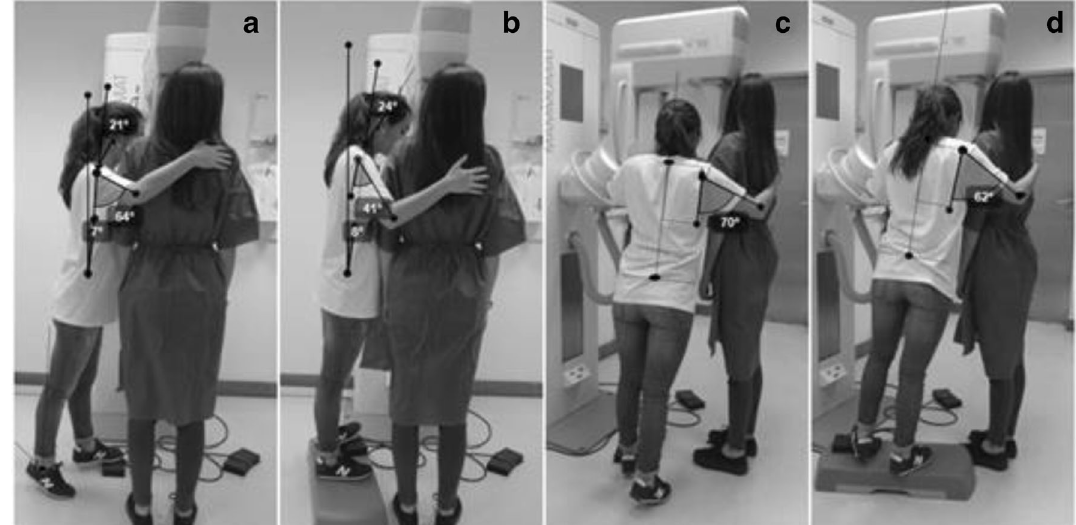
Fig. 3 CC breast positioning: a and c radiographer postures without intervention; b and d alternative postures when the radiographer smaller than the